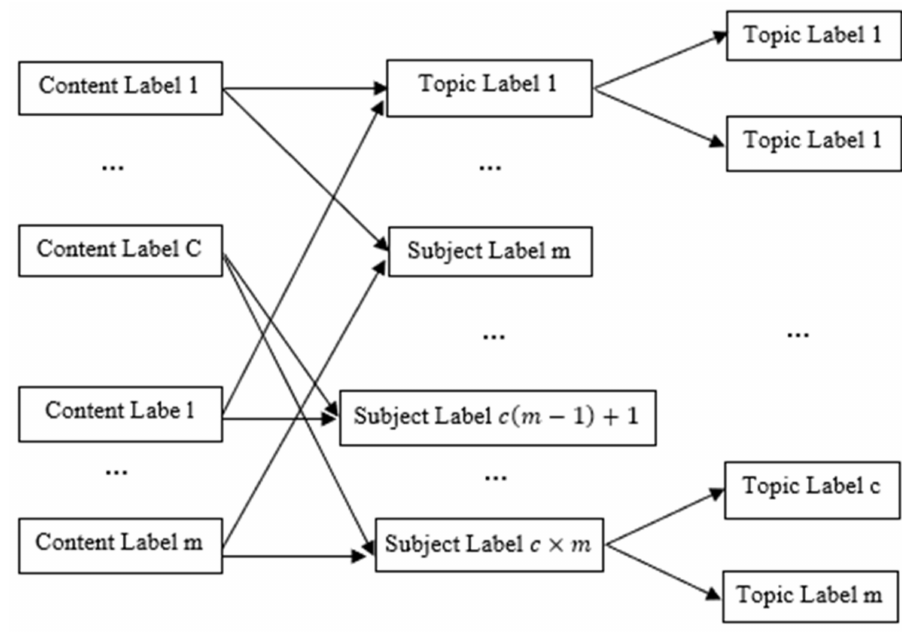
Figure 6. Process of implementing dual-label classification of